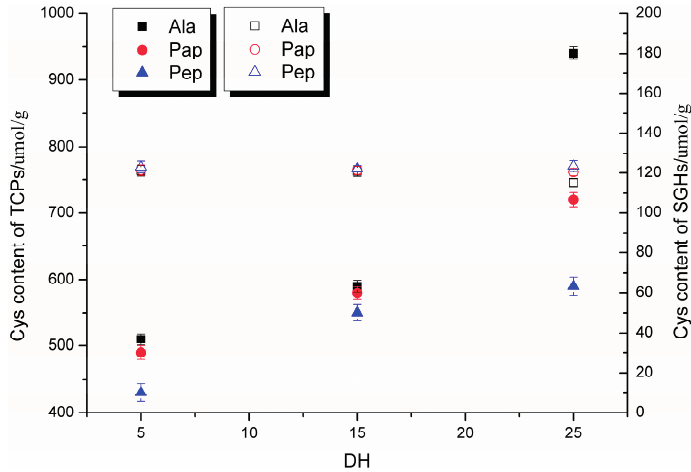
Figure 2. Total sulfhydryl group content of SGHs ( □ , ○ , Δ ) and sulfhydryl group content of thiol-containing peptides (TCPs) ( ■ , ● , ▲ ) with different DH. Total sulfhydryl group content of SGHs was determined after reduction of disulfide